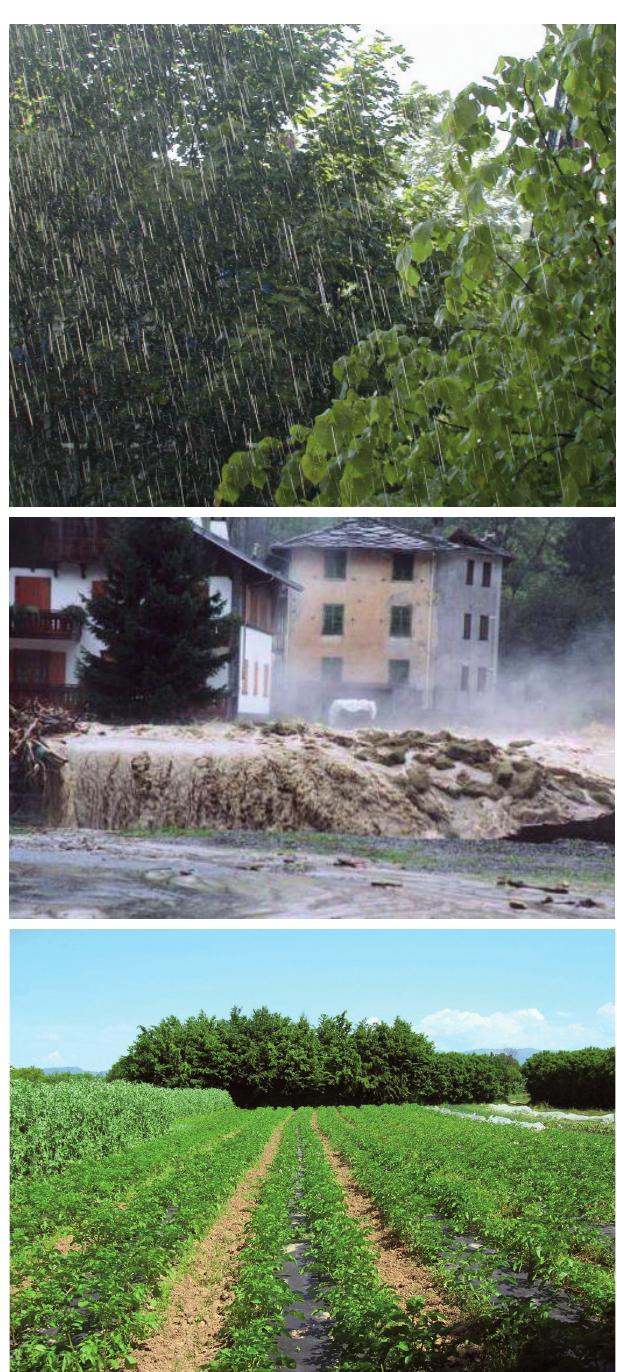
Figure 5. Listening to the sound of a storm evocates either a flood or the watering of the land. These effects can be considered positive or negative, depending on the season and the territory